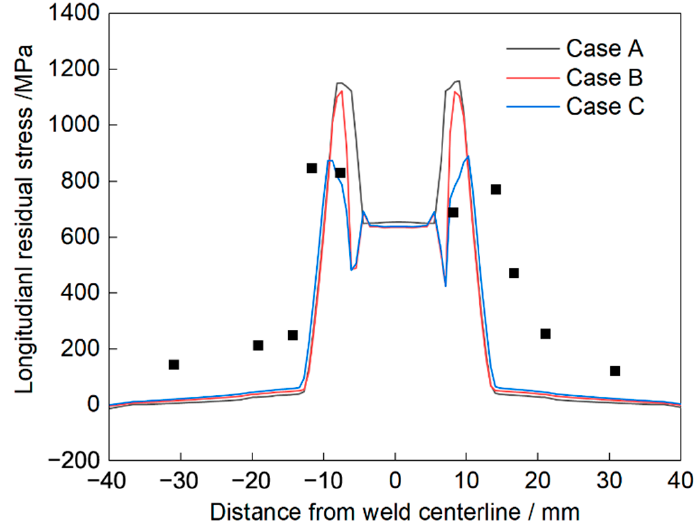
Figure 16. Longitudinal residual stresses distributions on central section of welded joint.